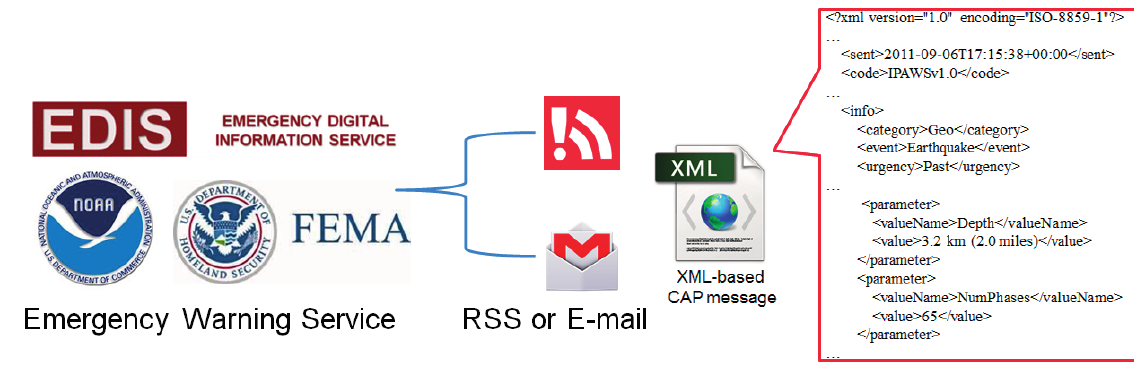
Figure 4. CAP messages published by an early warning system (EWS). EDIS, Emergency Digital Information Service.